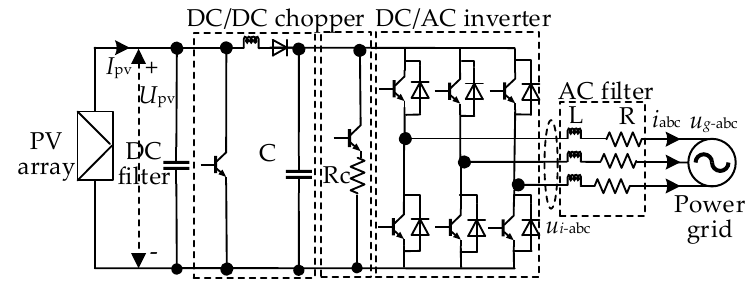
Figure 1. Grid-connected topology of PVGU.